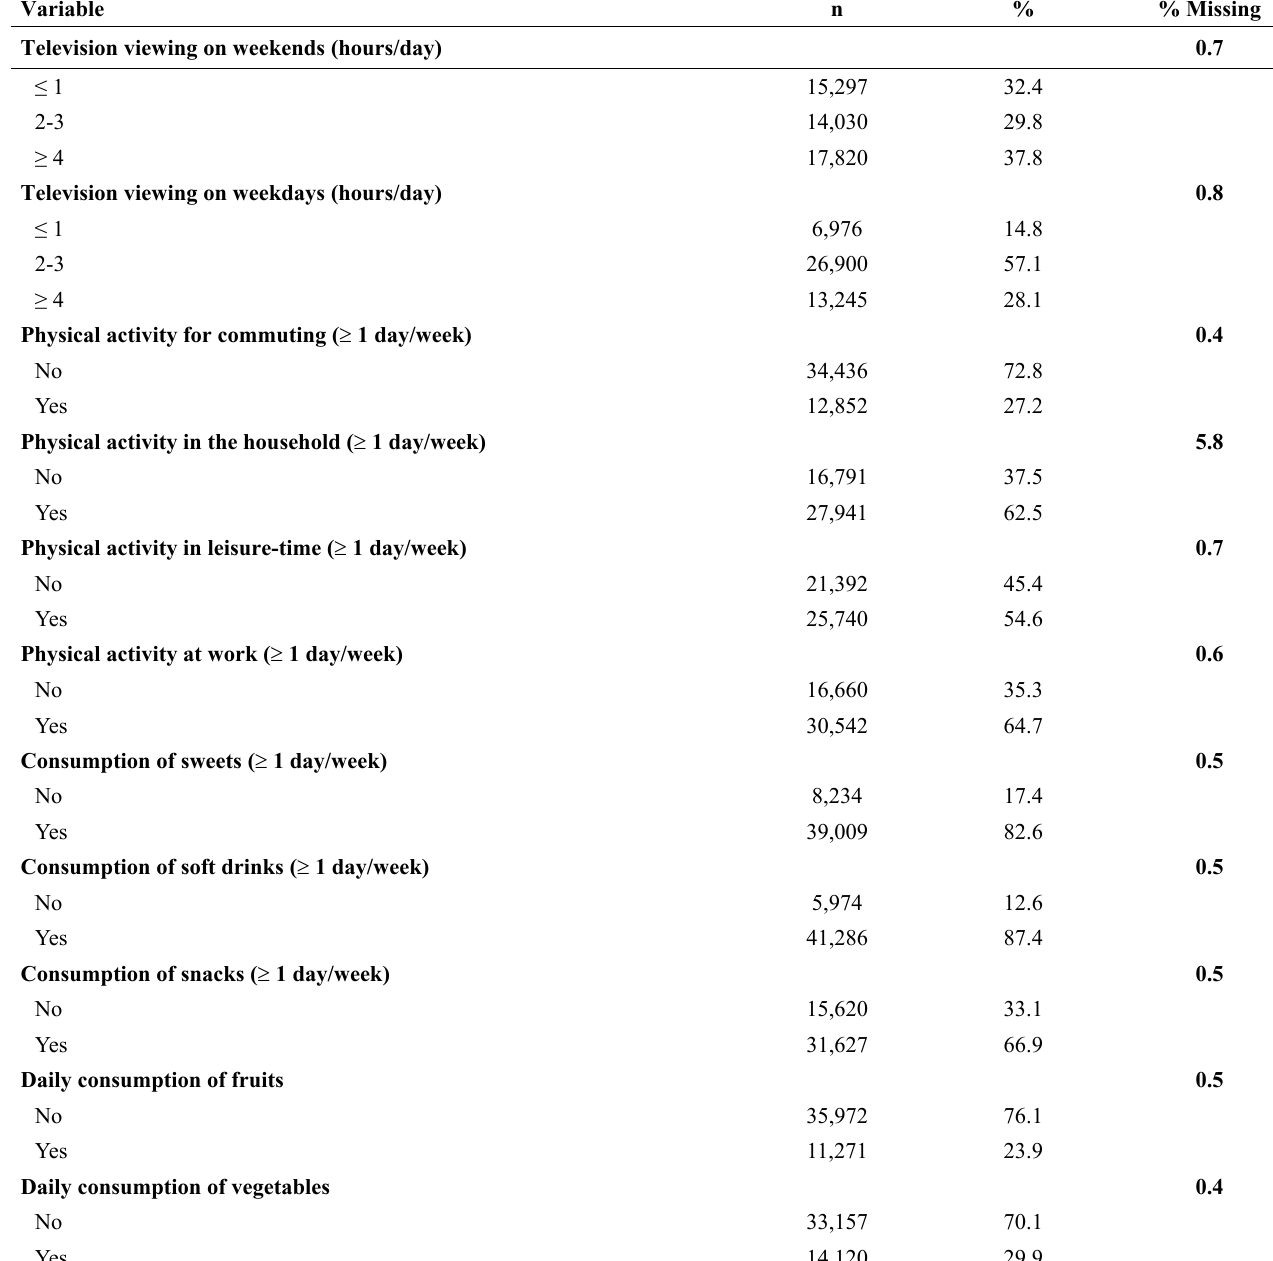
Table 1. Physical activity indicators and eating habits in industry workers. Brazil, 2006-2008 (n = 47,477). Variable